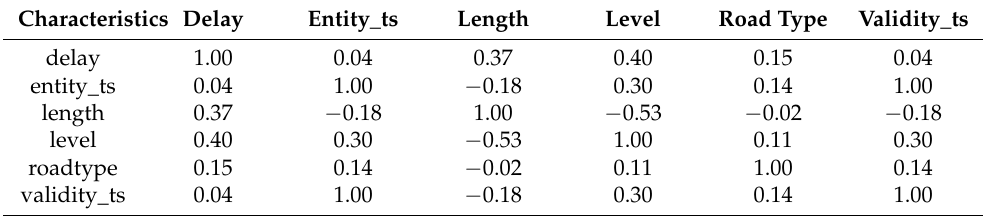
Table 8. Pearson correlation table.